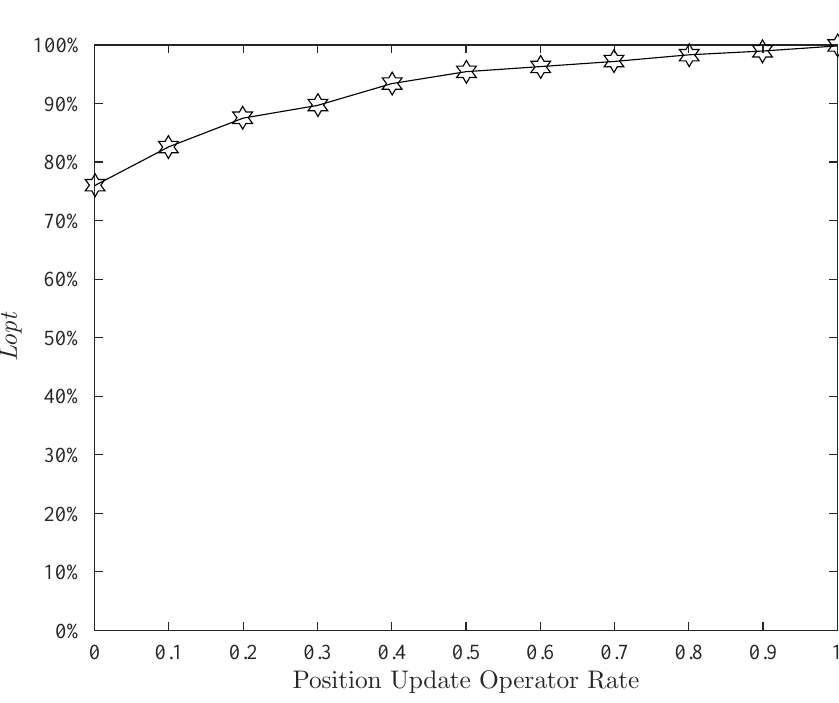
Figure 18. Effect of the smoothness operator rate.